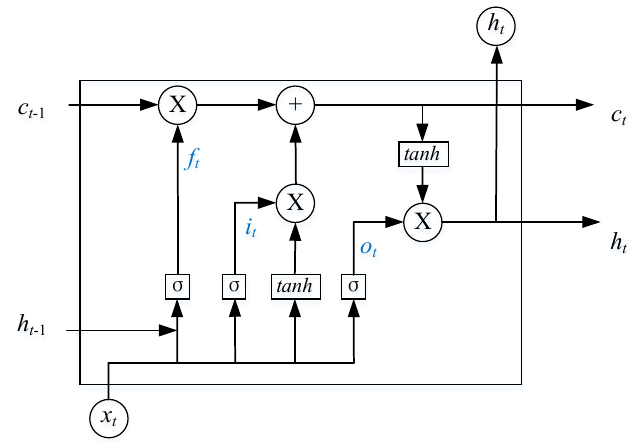
Figure 2. The diagram of the basic structure of an LSTM network. In Figure 2, and denote the state of the cell and the output of the hidden c h − − 1 t 1 t c , and layer at time t − 1, respectively; h respectively denote the input data, the x , t t t